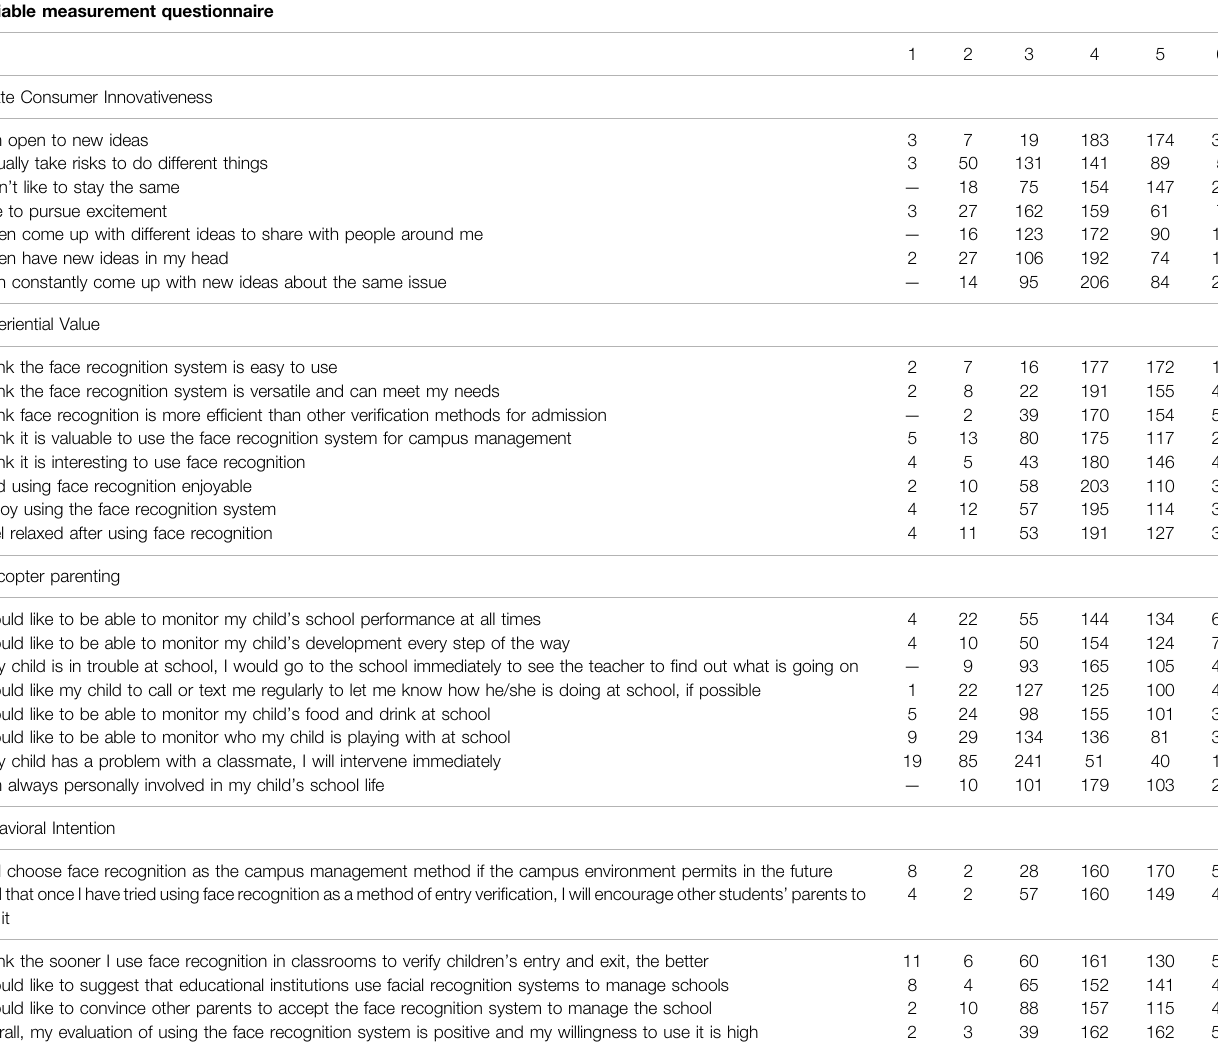
TABLE 2 | Data of the